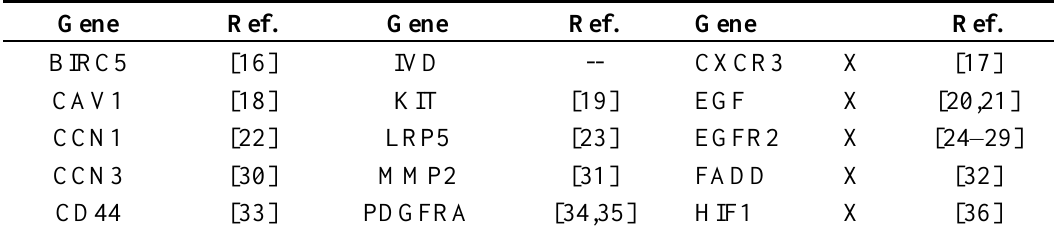
Table 2. Genes previously implicated in metastatic progression of OS. Gene Ref. Gene